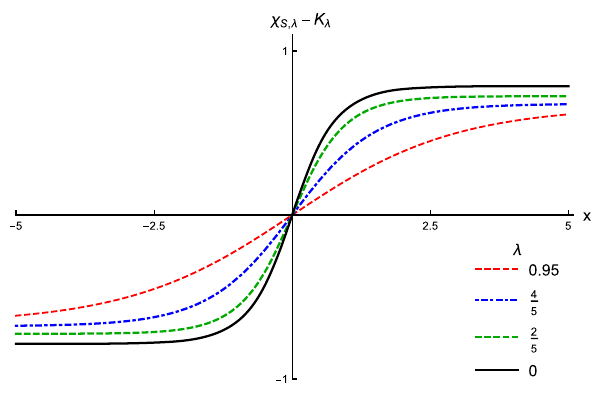
Fig. 1 The potential (23) for some values of λ and θ 2 = 1 − λ . As λ increases in the interval [ 0 , 1 ] , the model evolves from the sine-Gordon model at λ = 0 to a double sine-Gordon model and finally to the vacuumless model, at λ = 1